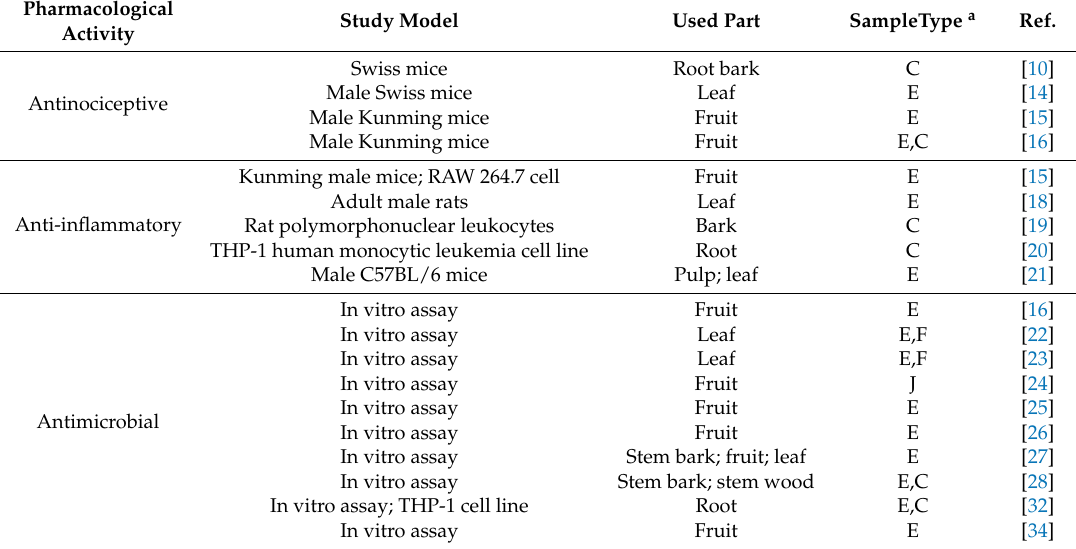
Table 1. Summary of major biological and pharmacological therapeutic activities of M. nigra